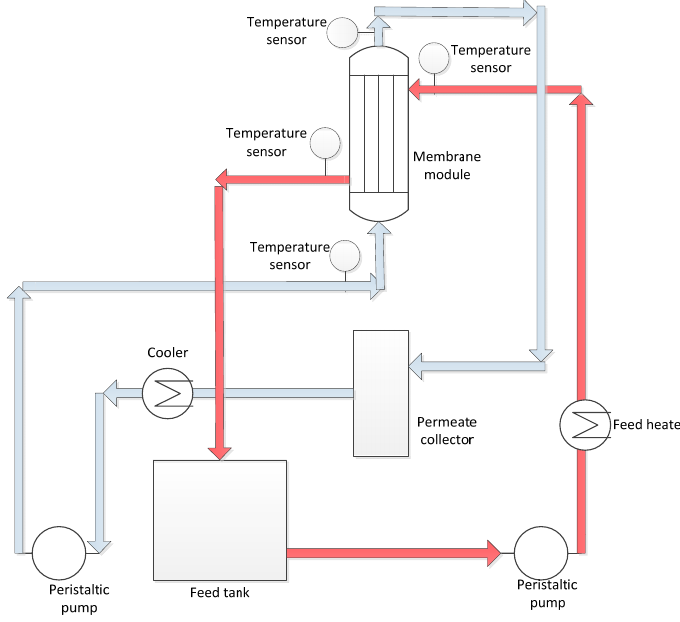
Figure 1. Schematic diagram of the set-up used for